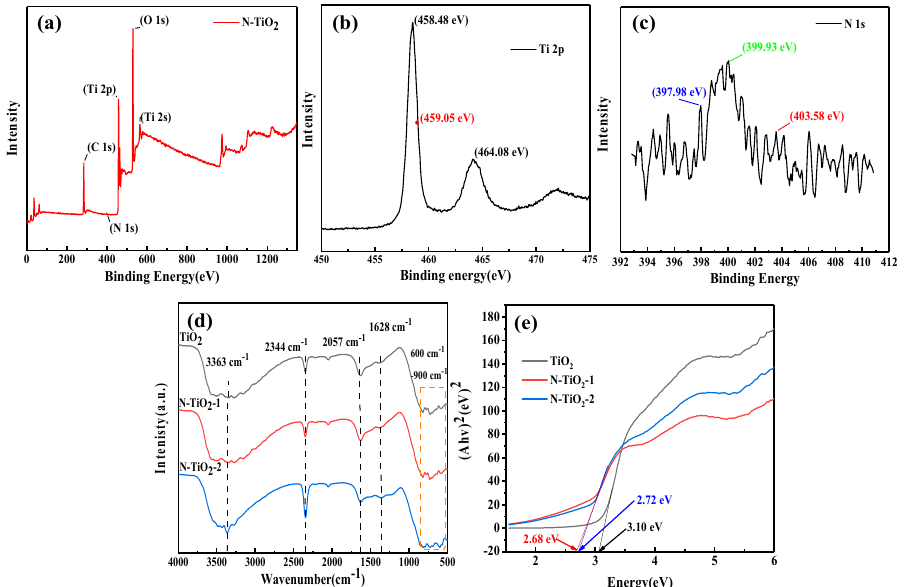
Figure 4. The XPS spectras of N-TiO 2 -1 ( a ); Ti 2p ( b ); N 1s ( c ); FT-IR pattern of N-TiO 2 -1 ( d ); and band gap bandgap energies of di ff erent photocatalysts ( e ).